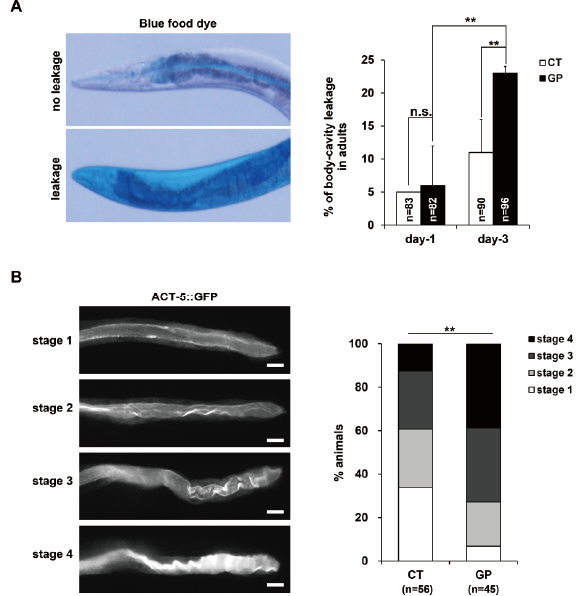
Figure 5. GP intake promotes intestinal disruption in adult C. elegans . ( A ) The presence of blue food dye in the body cavity indicates leakage of the intestinal barrier after 0 (CT) or 3 µM of GP treatment. Error bars represent SD. n.s.: not significant. ** p < 0.05 (chi-square test). ( B ) Transgenic worms expressing actin 5 (ACT-5)::GFP were treated with 0 (CT) or 3 µM of GP at the L4 stage for 3 days. The intestinal actin localization was classified into four stages depending on mislocalization in the apical side of the intestine. The percent distributions of the respective stage in worms are presented in the graph. Scale bars are 50 µm, ** p < 0.05 (chi-square test).